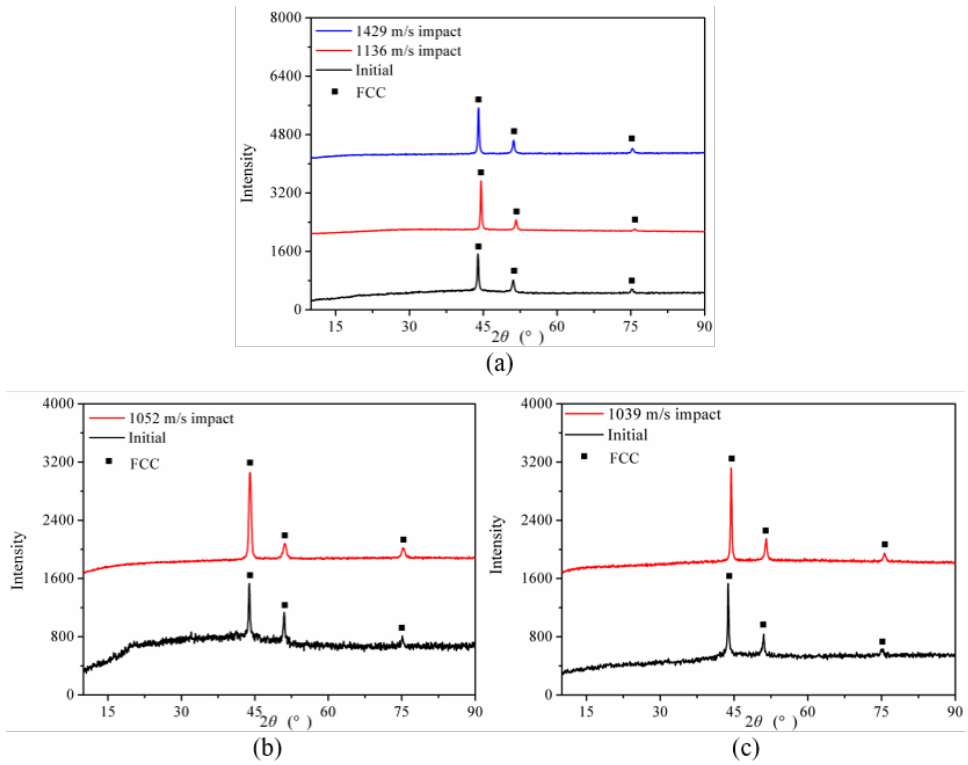
Figure 17. XRD patterns of the projectiles picked up: ( a ) initial FeNiCoCr HEA LRPs, ( b ) FeNiCoCr HEA LRPs annealed at 850 °C and ( c ) FeNiCoCr HEA LRPs annealed at 1000 °C.